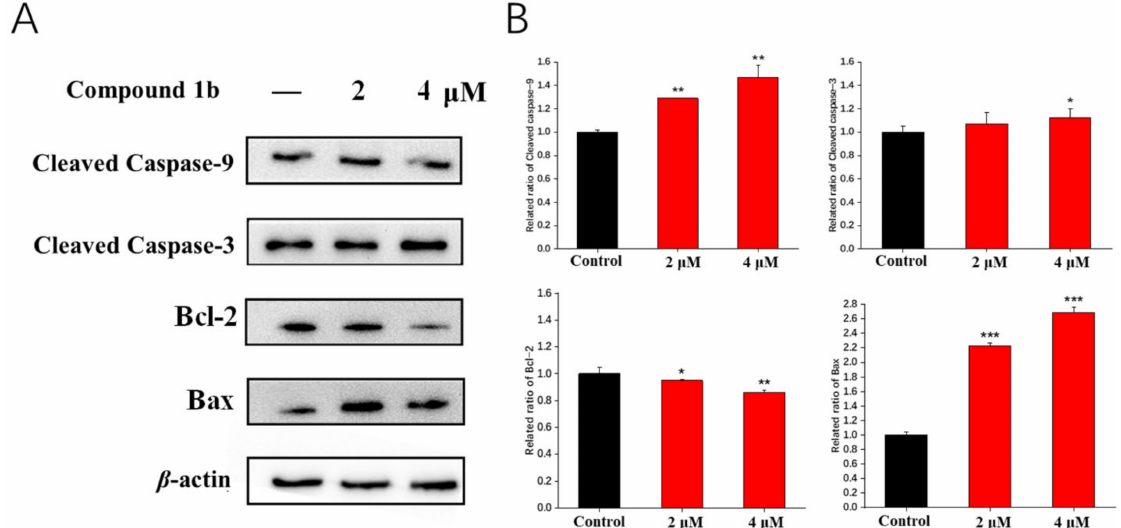
Figure 5. Effects of compound 1b on the expression of four apoptosis-related proteins. Cells were treated with compound 1b at the indicated concentrations for 48 h. ( A ) Representative images of Western blotting analysis of cleaved caspase-9, cleaved caspase-3, Bcl-2, and Bax. ( B ) Quantitative analyses of Western blotting are presented as the means ± SD ( n = 3). * p < 0.05, ** p < 0.01, *** p < 0.001 vs. the control